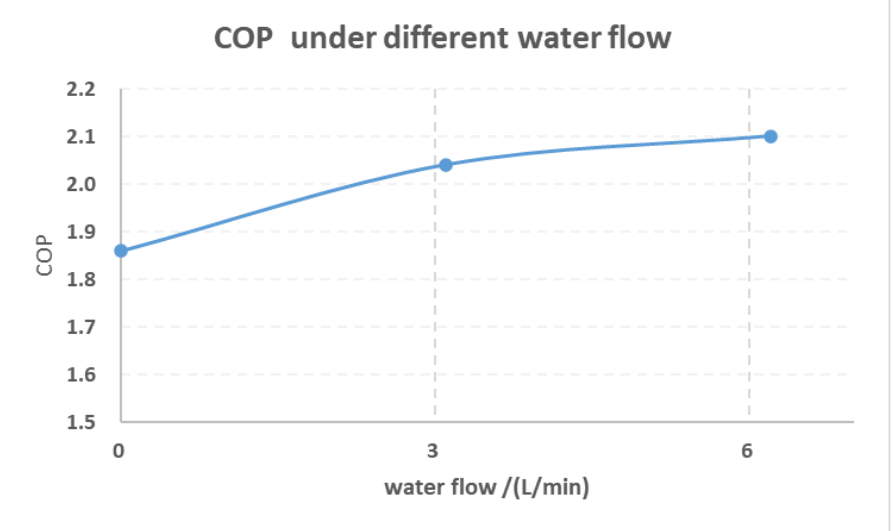
Figure 7. COP along with different water flows.